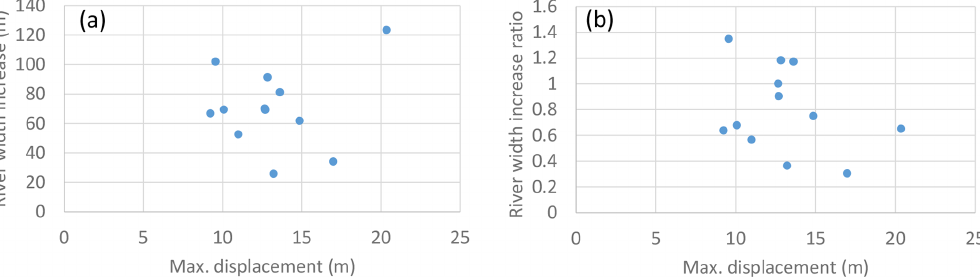
Figure 8. Relation between measured maximum slope displacements, river width increase (a) , and ratio of river width increase (to the pre-disturbed river width) (b) .